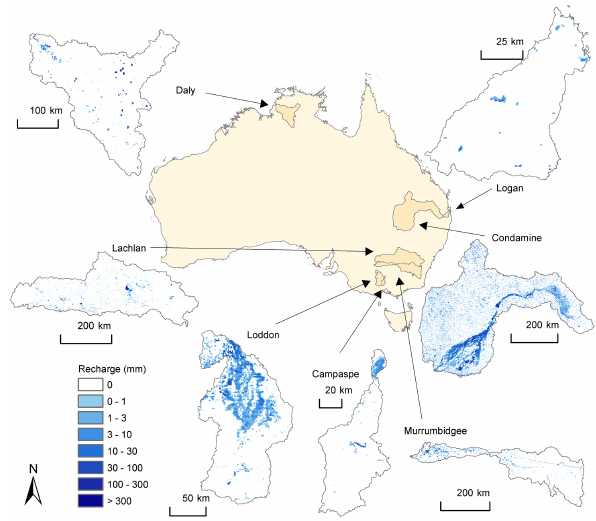
Fig. 3. Maps of the flood recharge for the seven catchments for the floods between 1 November 2010 and 31 March